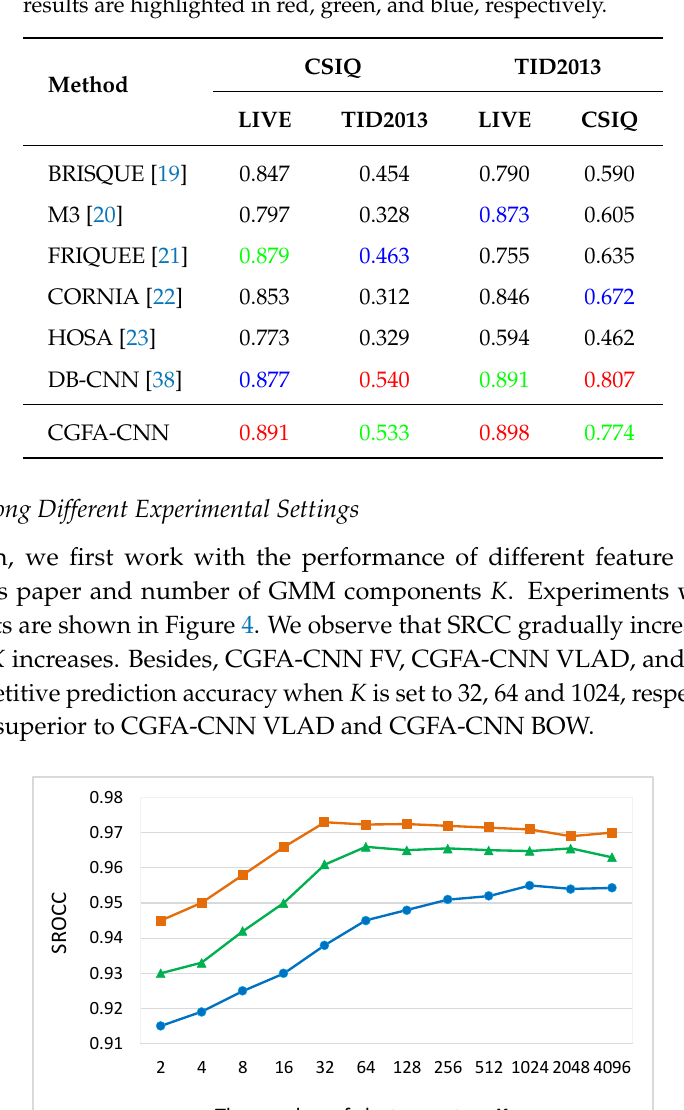
Table 6. SRCC comparison on cross-database. The top three SRCC results are highlighted in red, green, and blue, respectively.